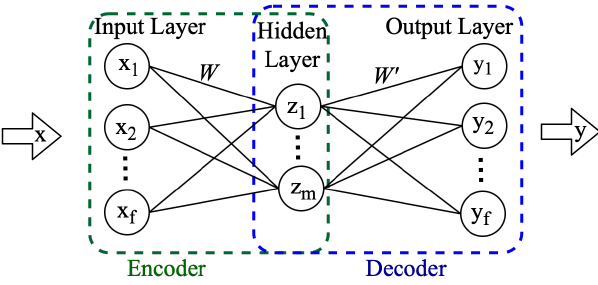
Figure 1. Conventional Autoencoder structure.